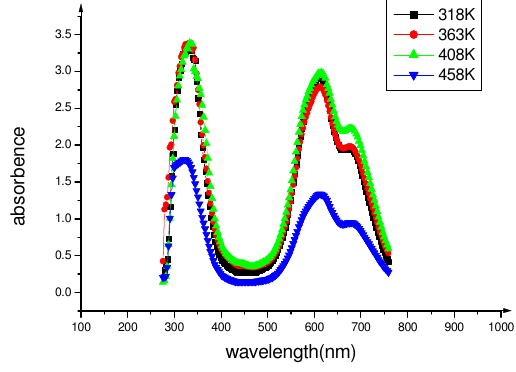
Figure 1 . The absorption spectra for cobalt phthalocyanine thin films deposited at 318, 363, 408 and 458K temperatures.